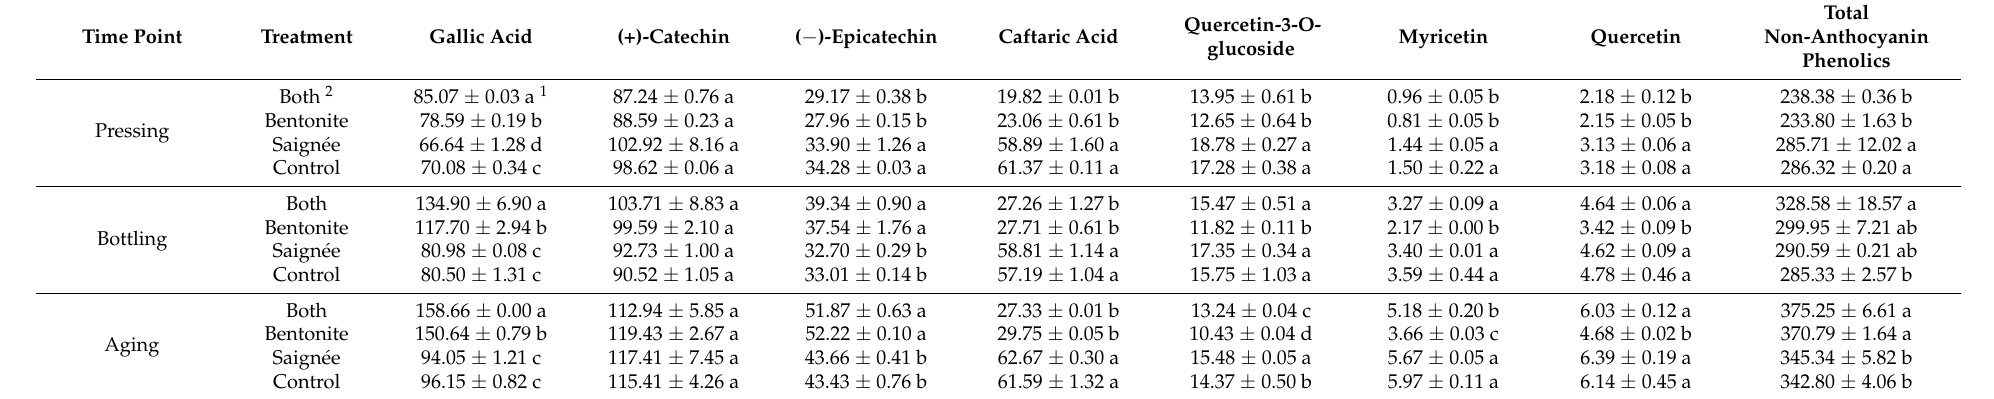
Table 3. Monomeric phenolic compounds (non-anthocyanin) content in Marquette grape musts and wines (in mg/L). Data were expressed as mean of replicate ( n = 2) ± standard